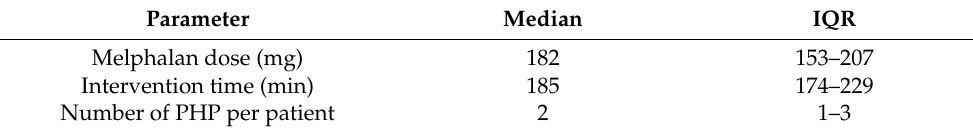
Table 2. Characteristics of the percutaneous hepatic perfusion (PHP) procedure ( n = 145).